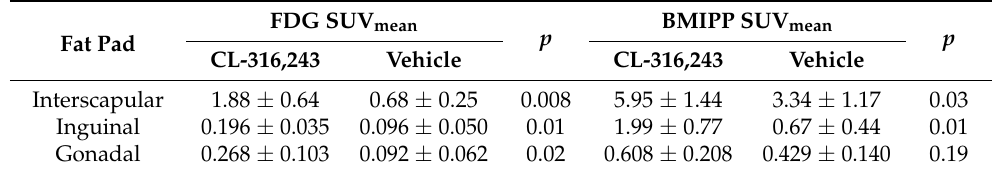
Table 1. Mean FDG and BMIPP SUVs in selected adipose tissue depots *. Figure 1. Representative sagittal 18 FDG-PET/CT of a CL-316,243 treated ( a ) and vehicle control ( b ) mouse and 125 I-BMIPP-SPECT/CT of a CL-316,243 ( c ) and vehicle ( d ) mouse ( n = 5). The classical interscapular fat pad is circled in image ( a ), cardiac uptake is indicated with orange arrows in ( a ) and ( d ), and prevertebral and anterior abdominal fat uptake indicated with yellow arrows in ( c ). Extensive hepatic, gastrointestinal, and mediastinal background uptake was seen with BMIPP but not FDG.